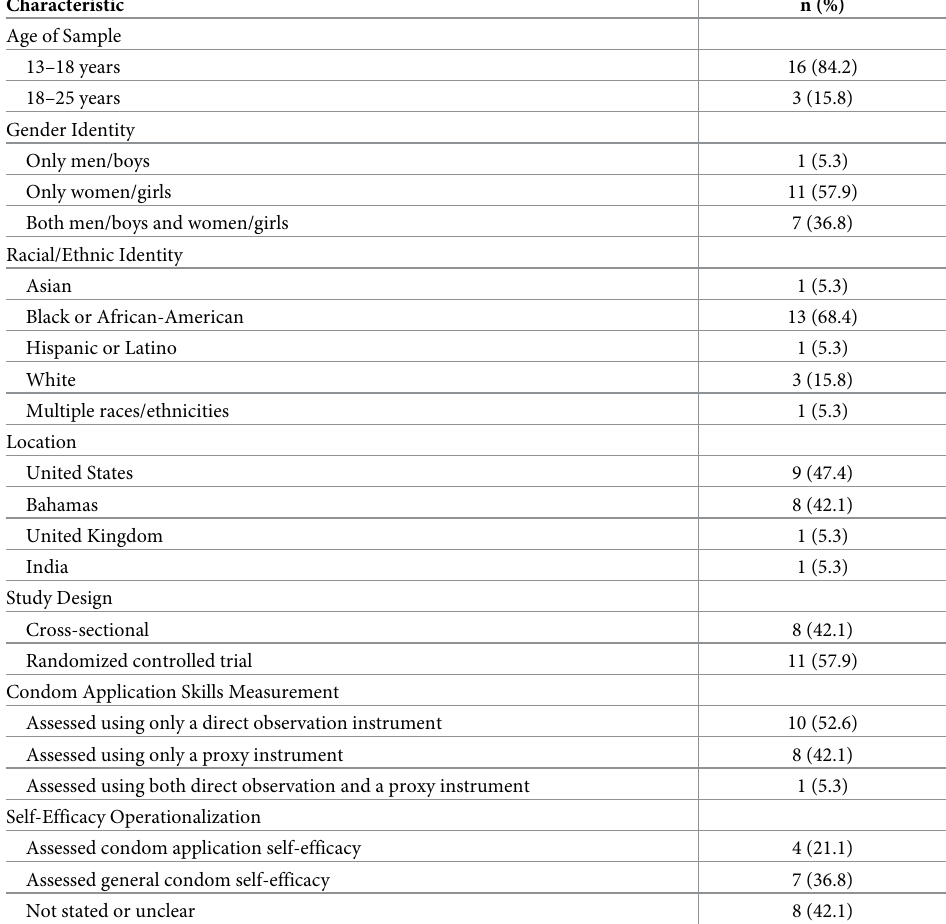
Table 1. General characteristics of studies included in a systematic review assessing condom application skills and self-efficacy in